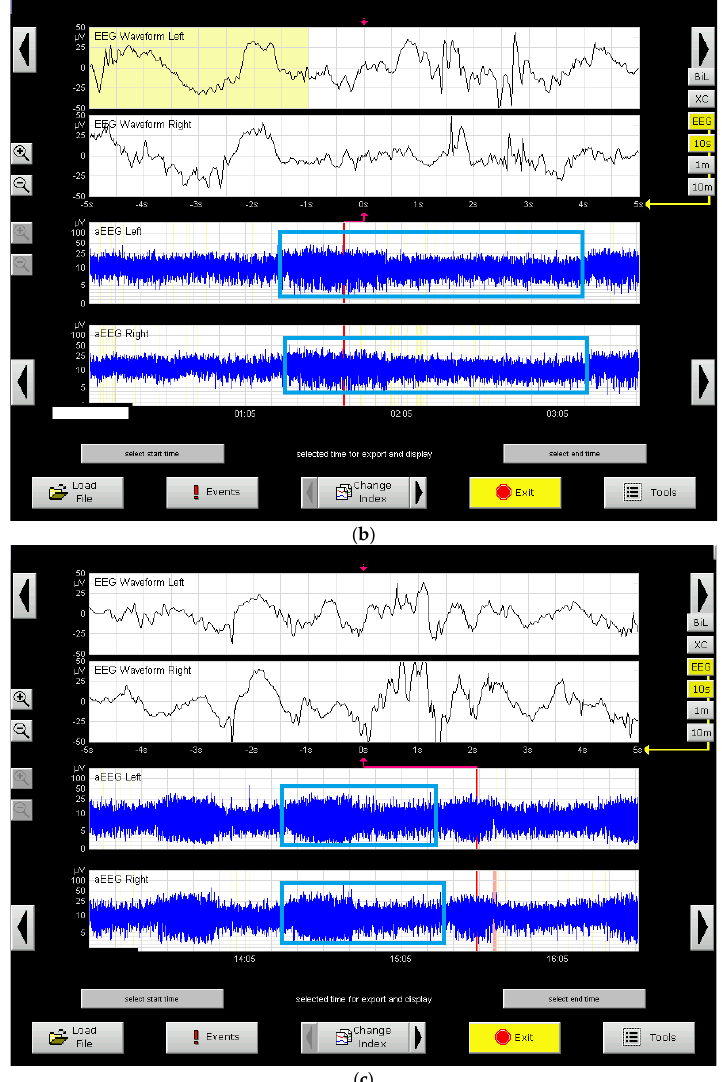
Figure 5. ( a ) aEEG monitoring. Sample tracings from 6 to 96 h of life. The upper 2 channels represent raw EEG-C3-P3; C4-P4 (raw tracing left and right on the figure). The lower channels (blue) represent amplitude integrated EEG (aEEG) (compressed tracing). The amplitude of both tracings is measured in microvolts-( µ V)-scale figured at the left of the tracing. Tracing at the beginning of the hypothermia-cerebral activity present, but a narrow band-width (black line in both lower-compressed tracings). This is to be compared to the two lower channels in ( b , c ), where the bandwidth is larger. (The significance of this finding is that the bandwidth is proportional to the number of neurons that are active and discharge impulses-a narrow bandwidth in the beginning signifies a lower number of active neurons due to asphyxia). ( b ) aEEG monitoring. Tracing at 48 h. Emerging sleep-wake cycles are noted on the compressed tracing (lower two channels-see above)-framed in light blue on the figure-with an enlarged bandwidth portion-representing a quiet sleep interval and a narrower bandwidth segment representing Rapid Eye Movement (REM) sleep or awake interval. The cycle is not so regular and with approximately equal segments to the normal sleep–wake cycle in ( c ). ( c ) aEEG monitoring of the patient-same channels as ( a ). Continuous normal voltage pattern. In the lower tracings, that represent the aEEG compressed tracing, a normal sleep–wake pattern could be noticed-framed tracing-the first half of the framed tracing represents the quiet sleep pattern with discontinuous activity-the larger bandwidth, the second half-the REM sleep or wakefulness-decreased bandwidth, more continuous